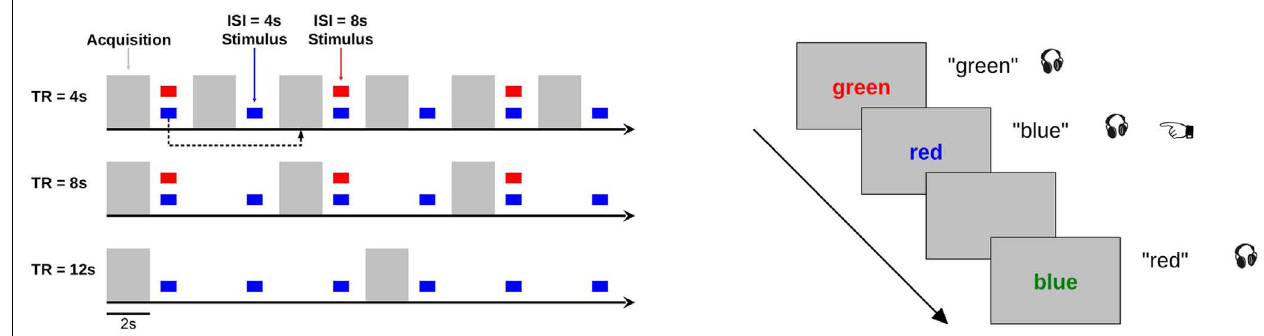
FIGURE 7 | Design of validation fMRI experiment. Neurophysiological responses to two stimulation rates (ISI = 4 and 8s) were measured during three acquisition rates (TR = 4, 8, and 12s). Gray bars depict acquisition times; colored boxes depict stimulation events. For boxcar models, the event was modeled at the acquisition ∼ 6s after stimulation in order to capture the peak of the hemodynamic response. For theTR = 8 and 12s acquisitions, this